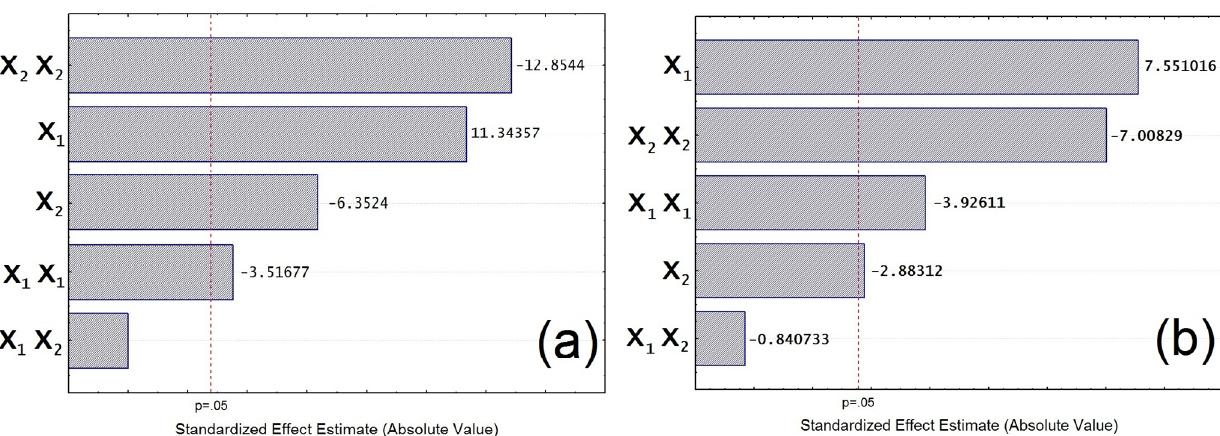
Figure 4. ( a ) Pareto graphics for hybrid copolymer dose and pH for turbidity removal model; and ( b ) Pareto graphics for hybrid copolymer dose and pH for COD removal model.